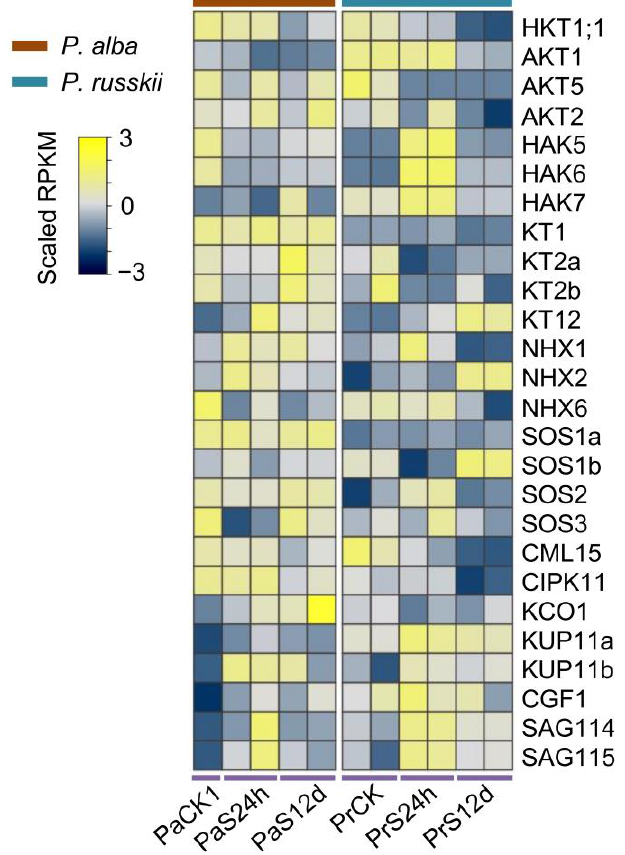
Figure 7. Heatmap showing the different expression patterns of the genes related to Na + or K + transportation in P. alba and P. russkii roots under salt stress. Two biological replicates were shown except for the control of P. alba .